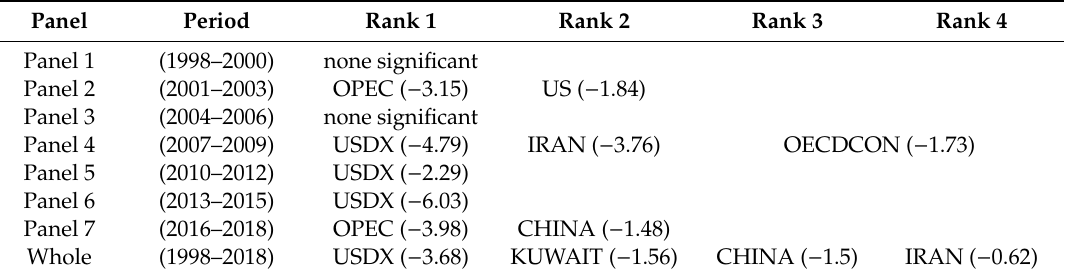
Table 19. Negative impact rank, based on significant coe ffi cient estimates at the 10%